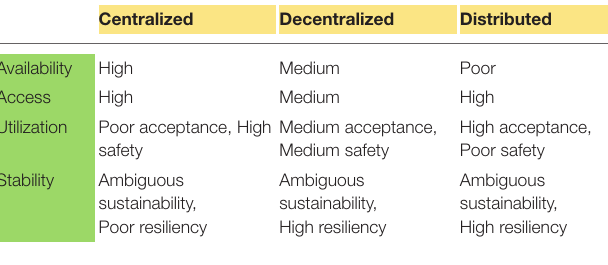
TABLE 1 | Overview of how potential cellular agriculture systems compare relative to each other on elements of food